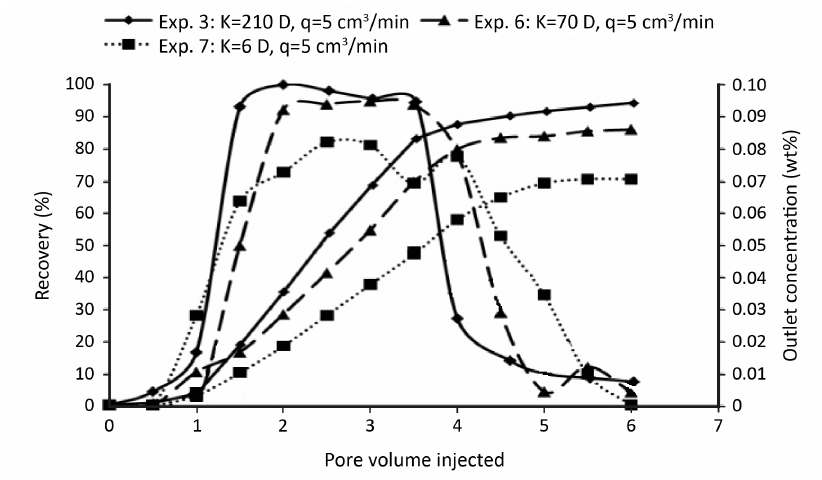
Figure 44. Effect of the absolute permeability and injection flowrate on the recovery of Ni nanoparticles and the outlet concentration. Figure reproduced from Ref.